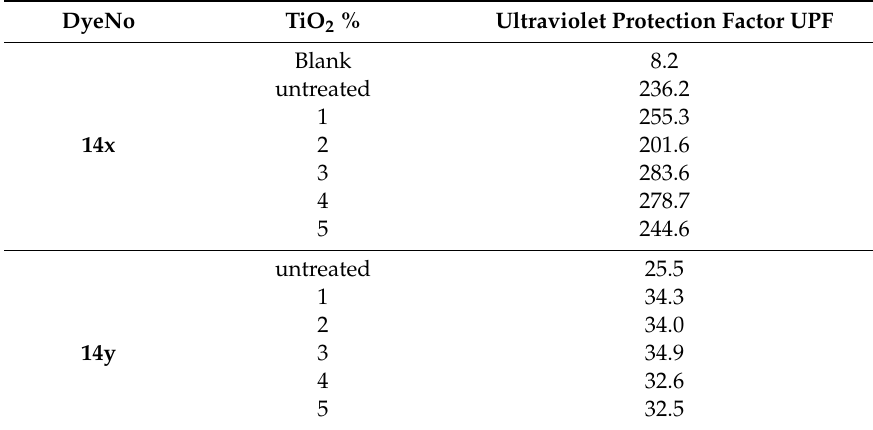
Table 5. UPF values of treated polyester fabrics.